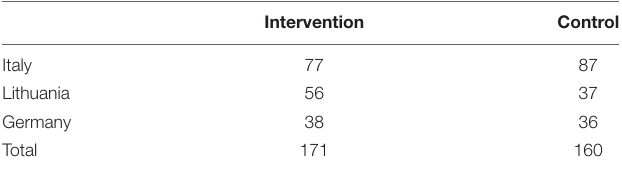
TABLE 1 | Participants per country distinguished in Control and Intervention groups. Intervention